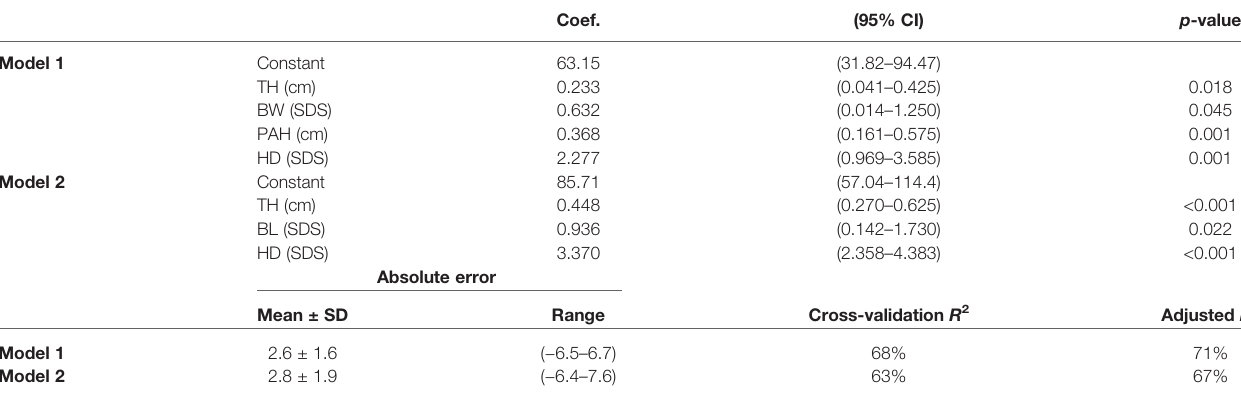
TABLE 4 | Predictive models of adult height at diagnosis. Leave-one-out cross-validation of the models.